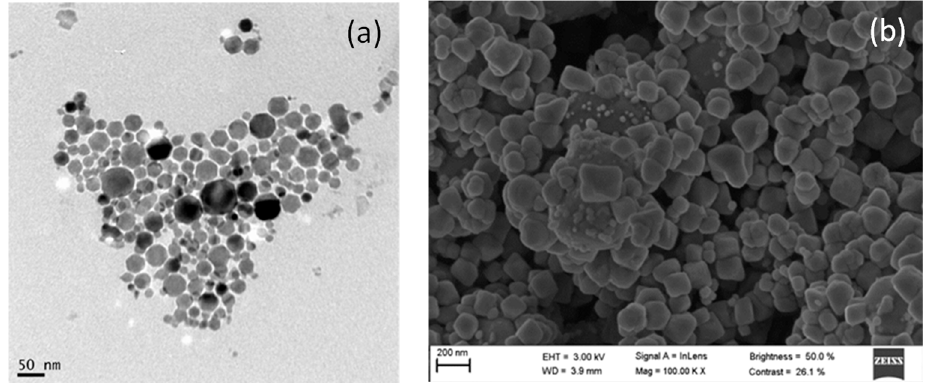
Figure 6. AgCl@Fe 3 O 4 nanocomposite: ( a ) TEM image, ( b ) SEM image.